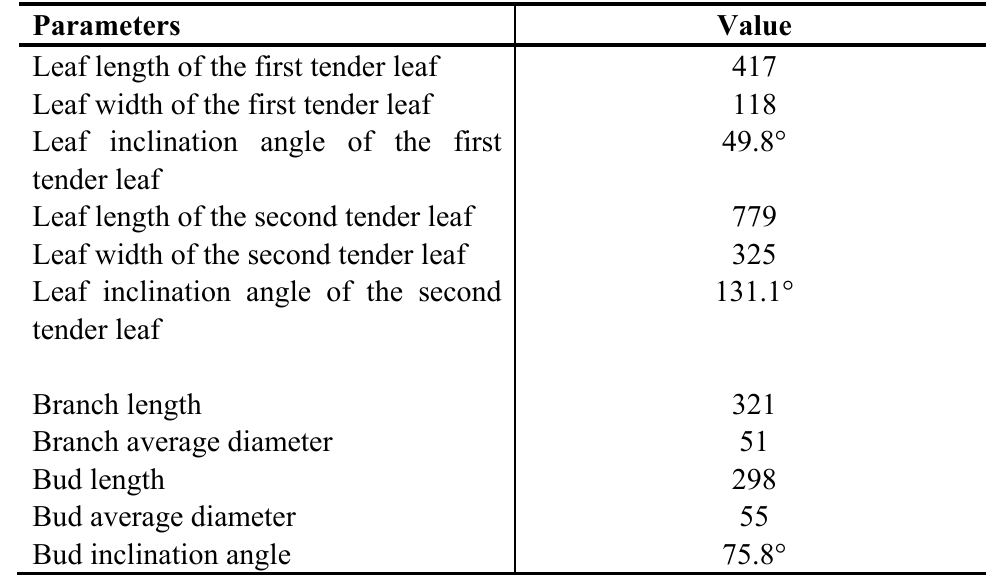
Table 1. The main parameter